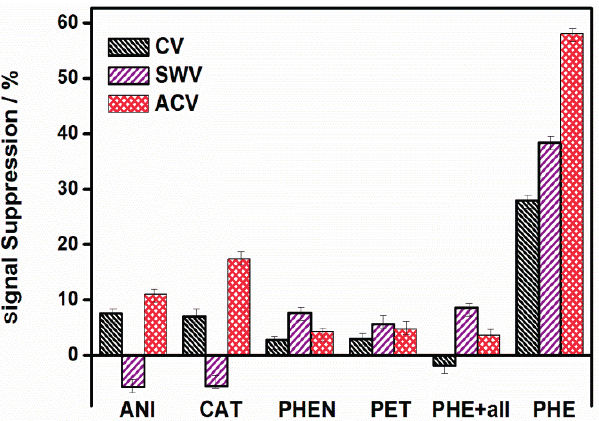
Figure 9. Sensor response to 1 µmol/L ANI (CI − , SO 42 − , NO 3 − ), CAT (Na + , Mn 2+ , Cu 2+ , Fe 2+ ), PHEN, PET, 1 µmol/L PHE with all inorganic/organic species (in a ratio of